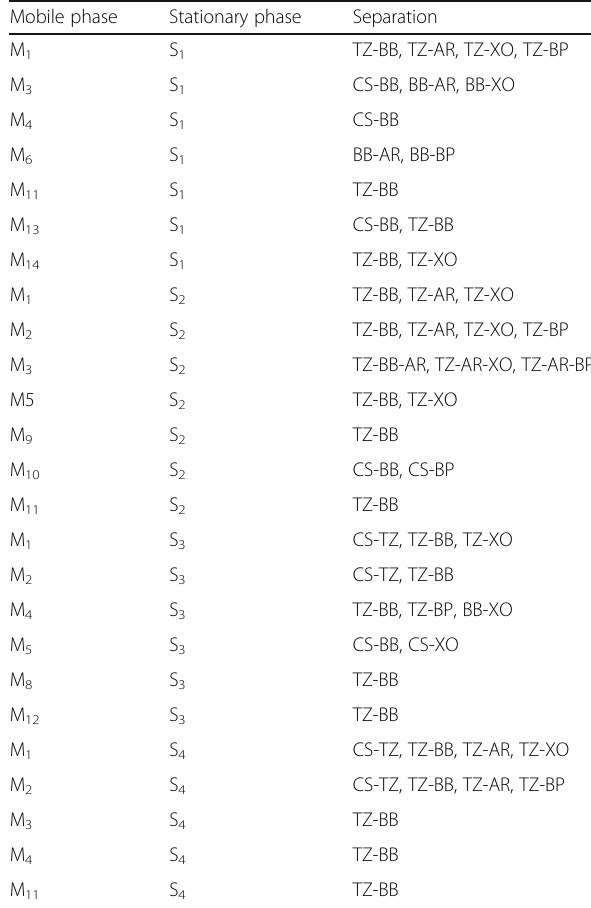
Table 7 Separated dyes on the nature of stationary phases developed with different mobile phases Mobile